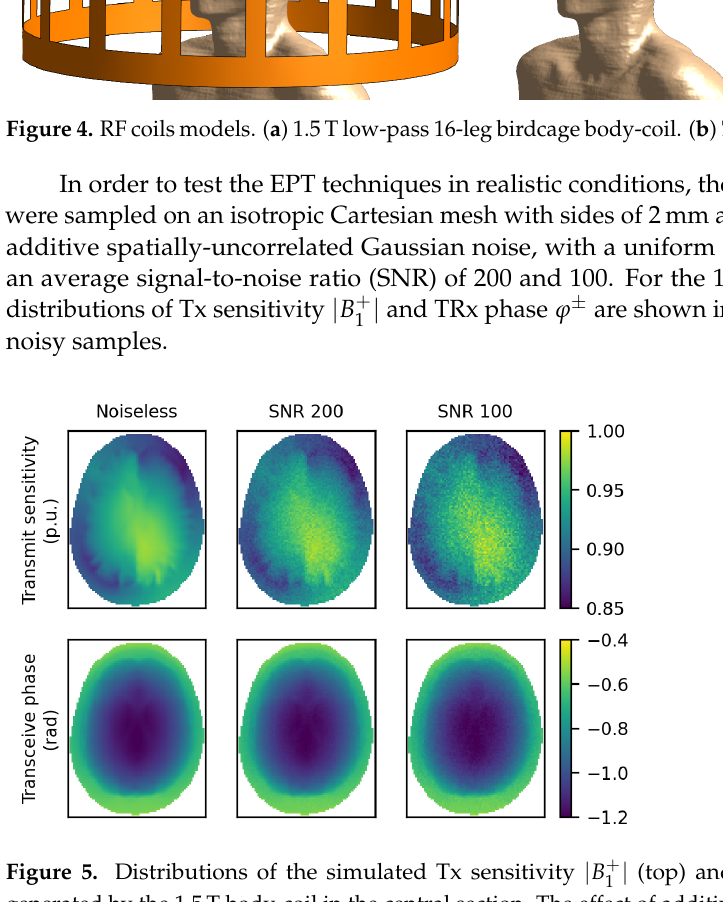
Figure 5. Distributions of the simulated Tx sensitivity | B + generated by the 1.5T body-coil in the central section. The effect of additive Gaussian noise is shown as